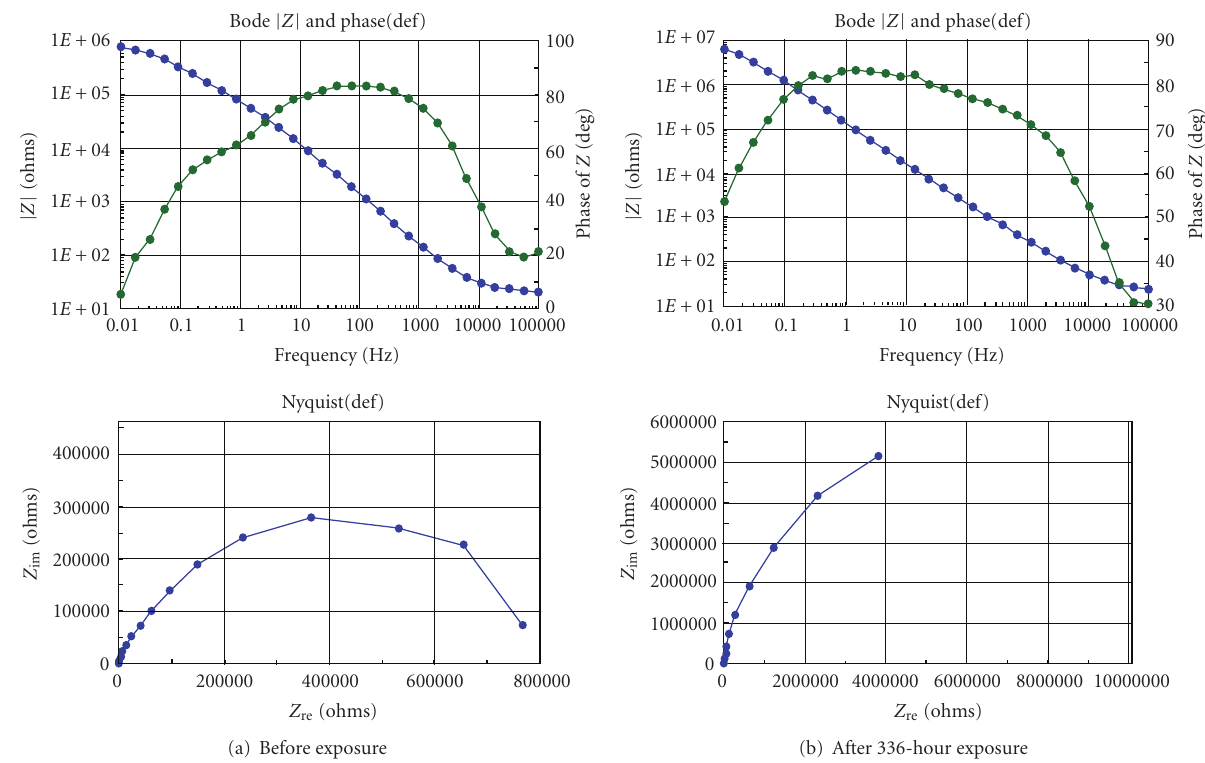
Figure 6: EIS Bode and Nyquist graphs before and after 336-hour exposure to accelerated degradation test of coated samples.